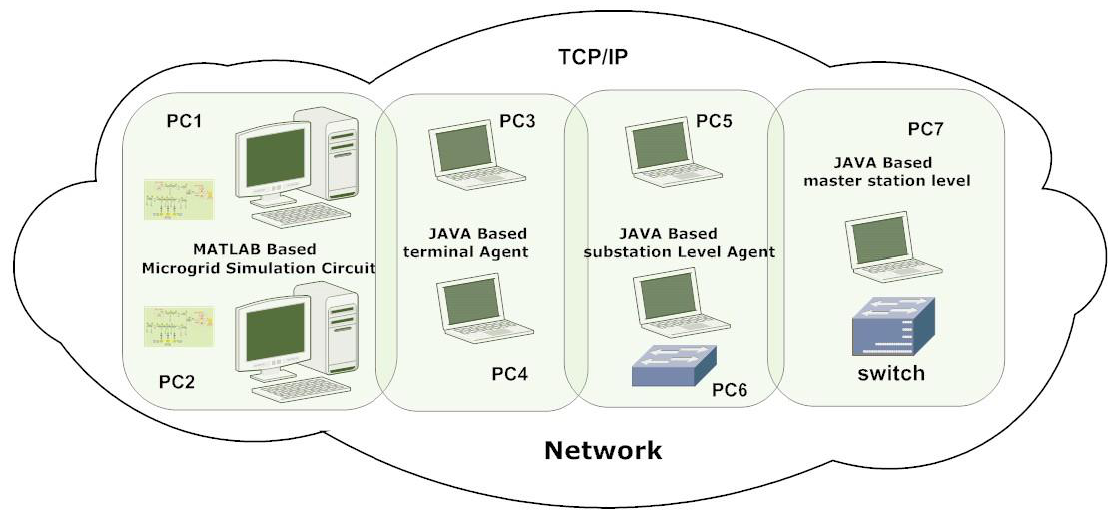
Figure 5. The framework of the hierarchical MAS for microgrid